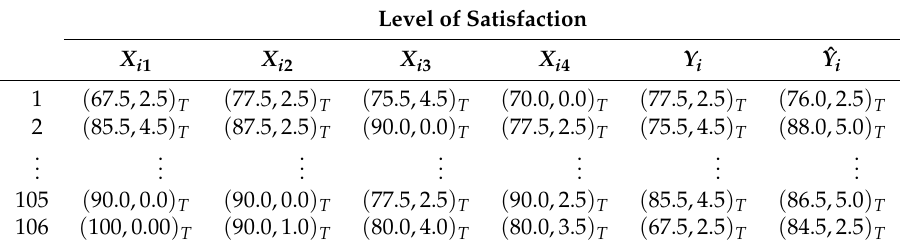
Table 6. Data for the satisfaction in Example